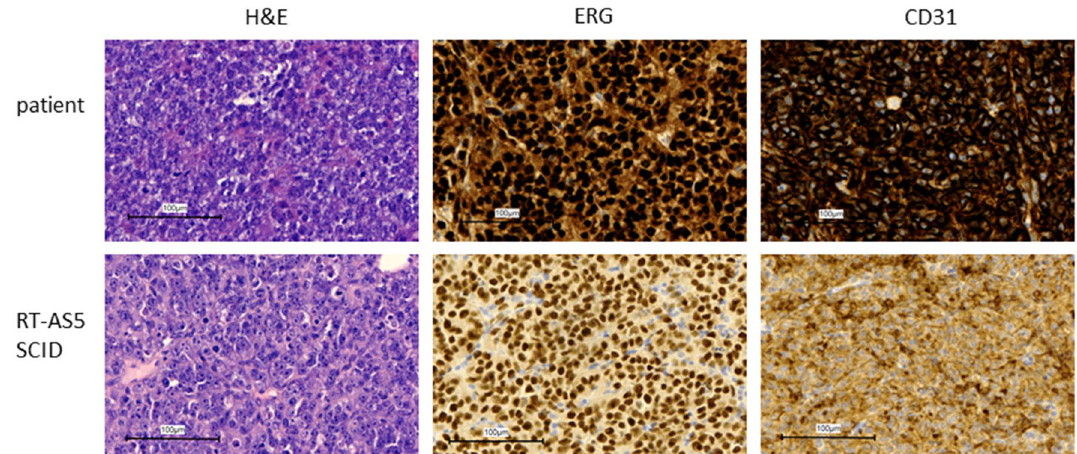
Figure 2. Characterization of the model. H&E, ERG and CD31 staining on patient and PDX